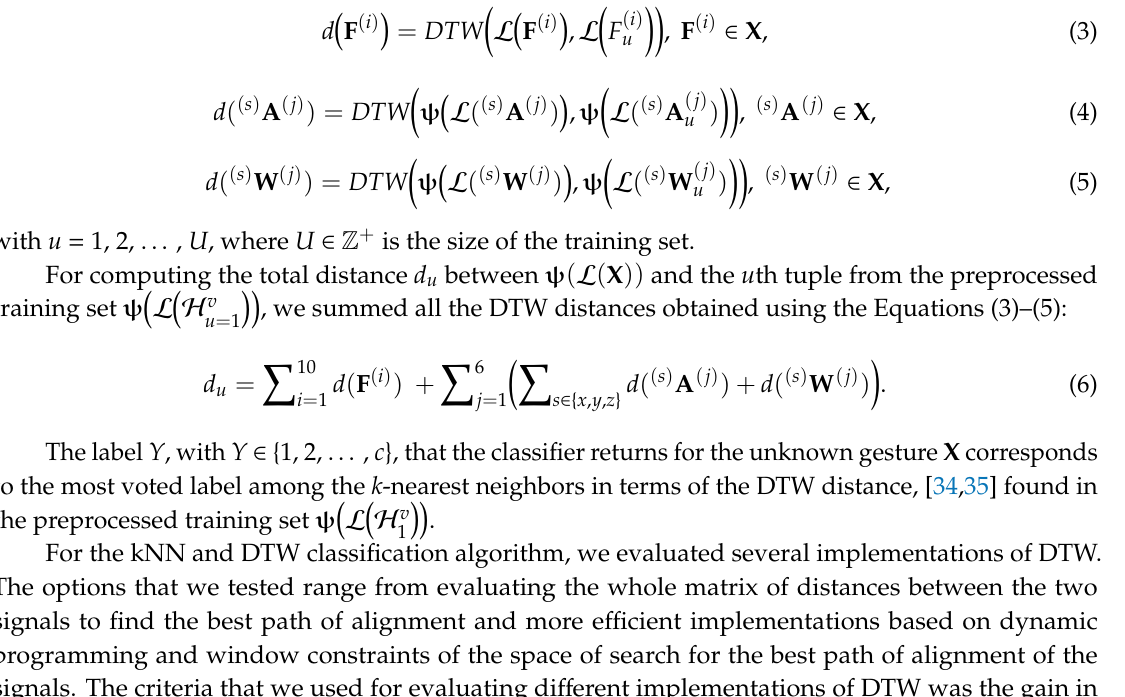
Classification: The classification assigns a label to a gesture X ∈ H U the k -Nearest Neighbors (k-NN) classifier and the Dynamic Time Warping (DTW) algorithm [32]. We computed a distance value d ∈ R + that represents the similarity between the